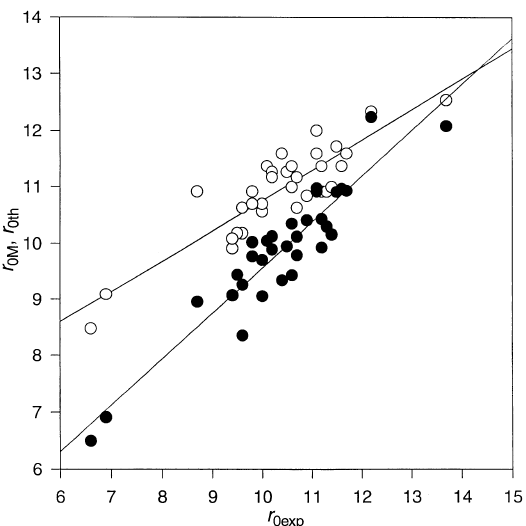
Fig. 3. Scatter plot of magnetopause stand-o(cid:128) distances calculated according to the Mead model ( open circles ) and the proposed model in this paper ( filled circles ). Thin lines represent linear regression lines